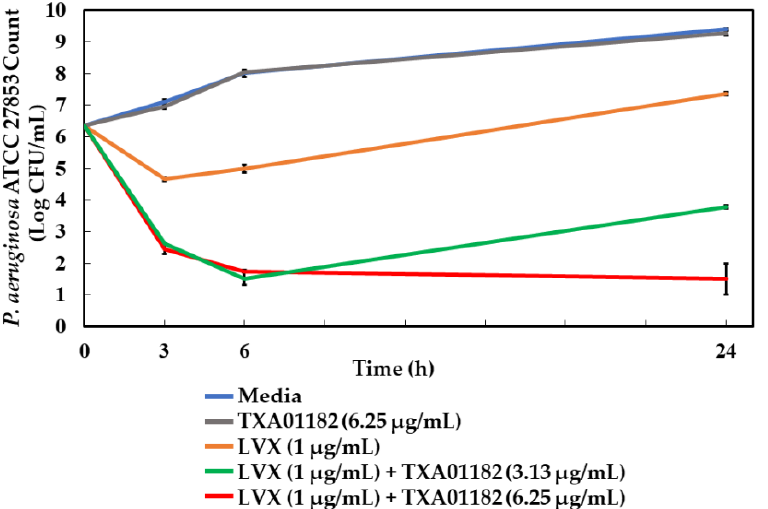
Figure 6. TXA01182 enhances the killing kinetics of levofloxacin (LVX). Time-kill kinetics of LVX alone and in combination with different concentrations of TXA01182 on P. aeruginosa . Values expressed as mean log 10 of CFU/mL. Error bars represent standard deviation.